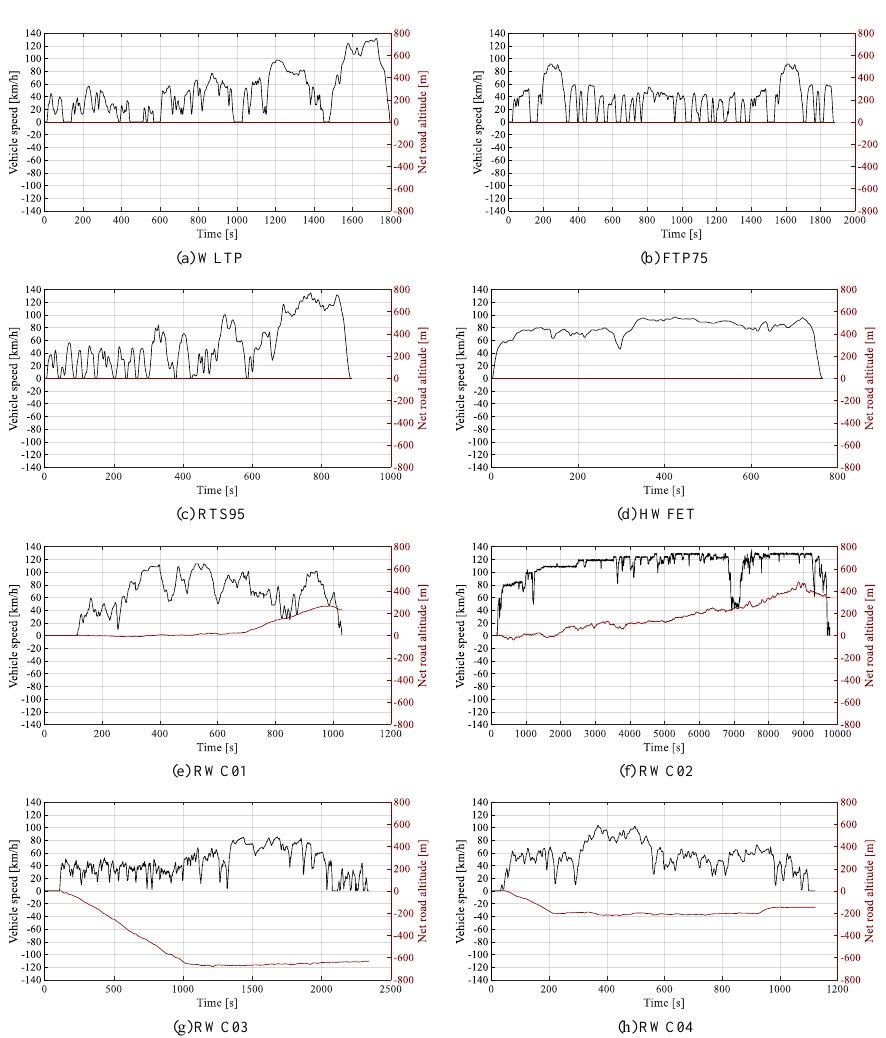
Figure A1. Vehicle speed and net road altitude profiles over time for the retained driving missions.